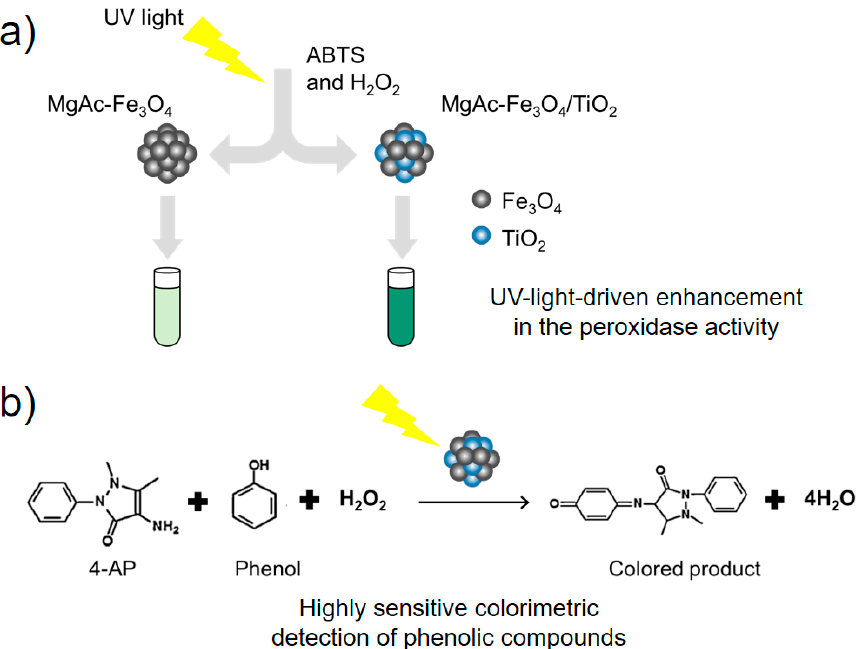
Figure 1. Schematic illustrations for ( a ) UV-light-mediated enhancement in the peroxidase-like ac- tivity of MgAC-Fe 3 O 4 /TiO 2 , and ( b ) its utilization for colorimetric detection of phenolic compounds. The morphologies of the as-prepared MgAC-Fe 3 O 4 /TiO 2 were observed and com- pared with the control samples (MgAC-Fe 3 O 4 and MgAC-TiO 2 ), via TEM and SEM (Figure 2). The results indicated that MgAC-Fe 3 O 4 /TiO 2 was successfully synthesized with an av- erage diameter of ~135 ± 45 nm, which is marginally larger than those of control samples. Energy-dispersive X-ray mapping (EDX) analysis from our previous reports indicated that TiO 2 was found to be uniformly distributed on the surface of MgAC-Fe 3 O 4 particles (Supplementary Materials Figure S1) [28]. Further, we analyzed the crystallinity of the synthesized nanohybrid. The XRD pattern of MgAC-Fe 3 O 4 showed peaks at 30.0°, 35.5°, 42.9°, 56.7°, and 62.0°, which corresponded to (200), (311), (400), (511), and (440) planes of Fe 3 O 4 magnetite, respectively (JCPDS 00-021-1272) (Figure S2) [26]. In the case of MgAC- Fe 3 O 4 /TiO 2 , besides the peaks corresponding to Fe 3 O 4 , there were additional peaks at 25.5°, 37.8°, 48.3°, 54.2°, and 62.8°, which corresponded to (101), (004), (200), (105), and (204) planes of anatase TiO 2 (JCPDS 00-064-0863), respectively, thereby confirming the presence of Fe 3 O 4 and TiO 2 crystals within the nanohybrid structure [25]. The calculated crystallin- ity degree of MgAC-Fe 3 O 4 and MgAC-Fe 3 O 4 /TiO 2 was ~58.60% and ~80.32%, respectively. XPS characterizations were then conducted to investigate the oxidation states of the ele- ments within the nanohybrid. The full-scan spectra indicated Mg, Fe, Ti, C, Si, and O, which corresponded to Mg-based aminoclay, Fe 3 O 4 , and TiO 2 within the nanohybrid (Fig- ure S3). In the high-resolution XPS spectra, the peaks at 710.4 and 723.5 eV were attributed to Fe 2p 3/2 and Fe 2p 1/2 , respectively, both of which revealed the presence Fe 3 O 4 in both MgAC-Fe 3 O 4 /TiO 2 and MgAC-Fe 3 O 4 (Figure S4a,c) [30]. Furthermore, in both MgAC- Fe 3 O 4 /TiO 2 and MgAC-TiO 2 , the peaks corresponding to Ti 2p 3/2 and Ti 2p 1/2 at 458.2 and 464.07 eV, respectively, were observed, confirming the presence of Ti 4+ state for TiO 2 (Fig- ure S4b,d) [31]. All these characterizations demonstrate that the nanohybrid was synthe- sized by successfully combining MgAC, Fe 3 O 4 , and TiO 2 .